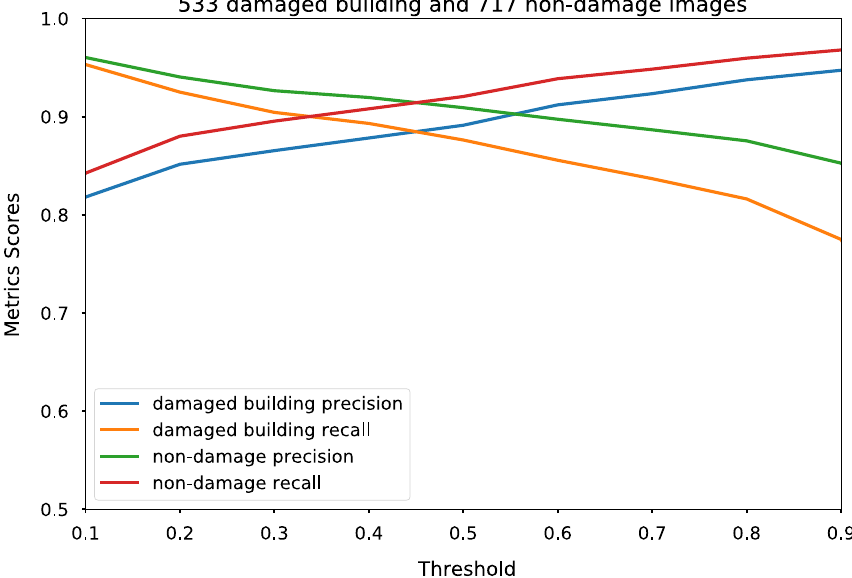
Figure 3. Performance of the trained model on the validation dataset . The horizontal axis shows the different decision thresholds, and the vertical axis shows the metrics scores for different metrics used. The four different colored lines are the precision and recall scores for damaged building and non-damage classes respectively.